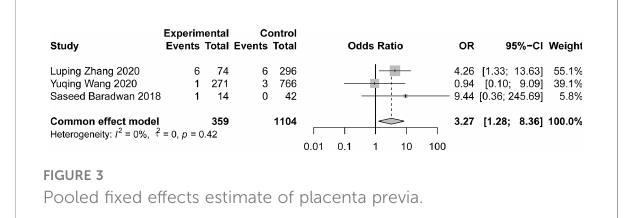
FIGURE 2 The quality of the papers.